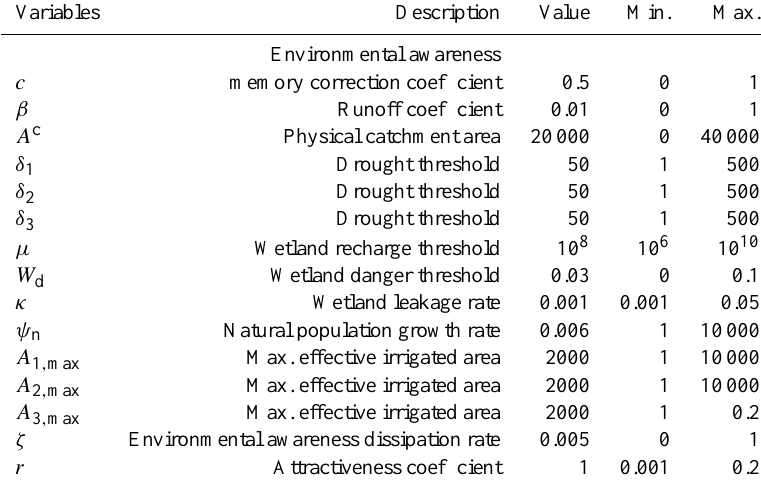
Table 4. Parameters tested during the sensitivity analysis, including the minimum and maximum values of the tested parameter range.